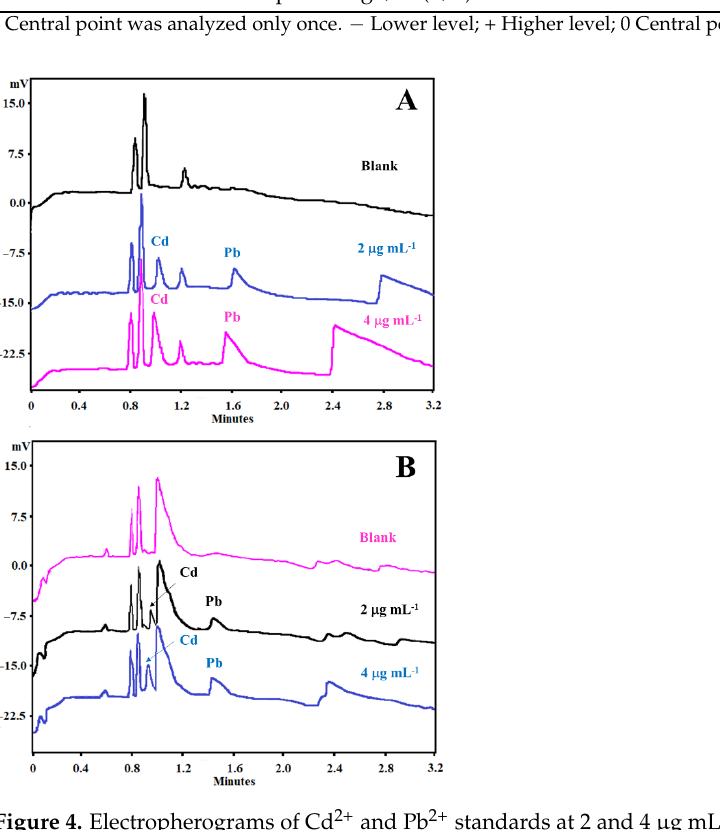
Figure 4. Electropherograms of Cd 2+ and Pb 2+ standards at 2 and 4 µ g mL − 1 spiked in ( A ) ultrapure water (black line, blank; blue line, 2 µ g mL − 1 ; pink line, 4 µ g mL − 1 ) and ( B ) Passiflora incarnata tea samples (pink line, blank; black line, 2 µ g mL − 1 ; blue line, 4 µ g mL − 1 ). Conditions: indirect mode, 12.2 cm effective length, 50 cm full-length capillary, BGE with 5 mmol L − 1 imidazole, 6 mmol L − 1 HIBA, 32.5 mmol L − 1 18-crown-6, 3.8% methanol, temperature at 20 ◦ C, hydrodynamic short-end injection (0.5 psi by 5 s), and detection at 214